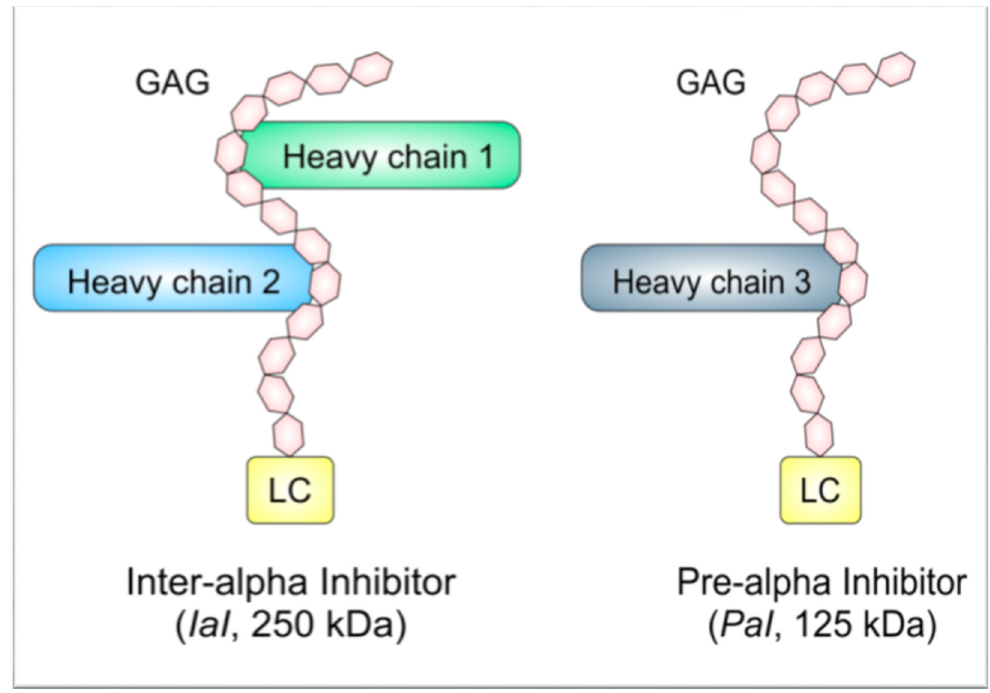
Figure 1. The structures of two major inter-alpha inhibitor proteins (IAIPs) endogenously present in serum, inter-alpha inhibitor ( IaI ; 250 kDa) and pre-alpha inhibitor ( PaI ; 125 kDa). IAIPs contain a glycosaminoglycan (GAG) backbone of chondroitin sulfate disaccharide repeats. Protein components, termed heavy chains, are connected to the GAG backbone. The light chain (LC; ~25 kDa) is present on both IaI and PaI . Heavy chains (HC; ~100 kDa) differ between IAIPs, with heavy chain 1 (HC1) and heavy chain 2 (HC2) on IaI and heavy chain 3 (HC3) on PaI.